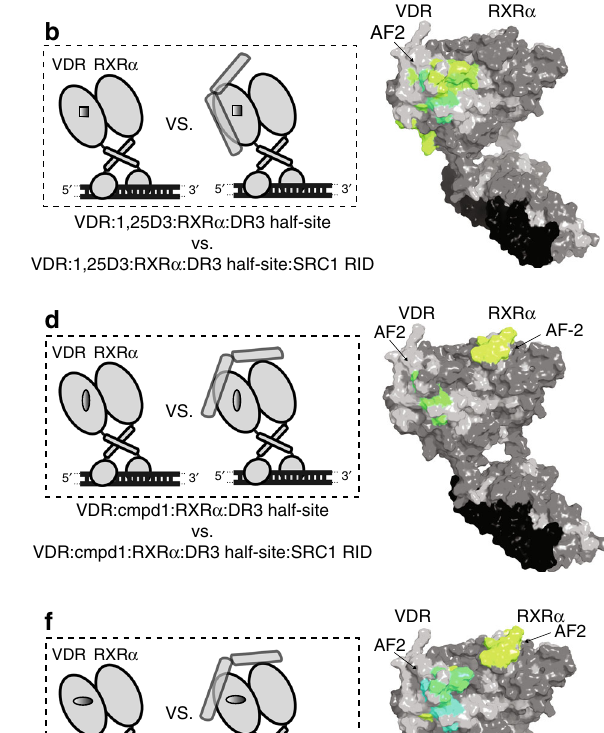
RID:1,25D3-heterodimer- TRPV6 complex. HDX analysis of both H12 residues aa411-419 of VDR (Fig. 5e, f, and i and